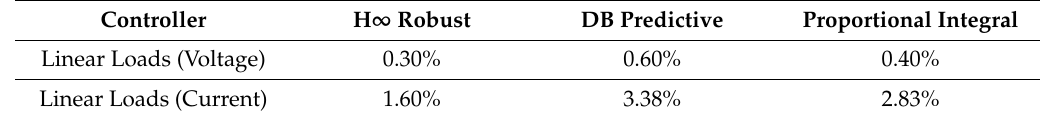
Figure 8. Simulation results with the PI controller in steady-state condition with linear loads. ( a ) Output voltage, ( b ) Load current, ( c ) d-frame voltage waveform, ( d ) d-frame voltage tracking error, ( e ) Voltage THD, ( f ) Current THD. Table 3. Voltage and current THD values at steady-state condition with linear resistive loads.